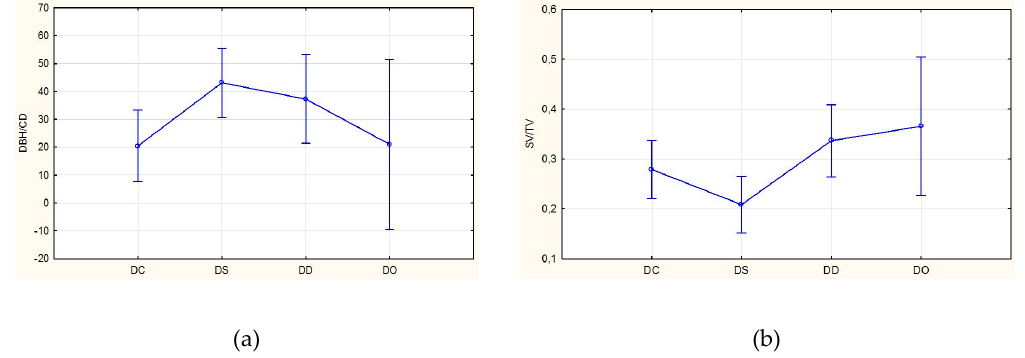
Figure 9. (a) Stem volume coefficient (SVC) computed as the ratio of stem volume to total volume (SV / TV). ( b ) Stem diameter coefficient (SDC) computed as the ratio of diameter at breast height to canopy depth (DBH/CD). Key: DC—Dracaena cinnabari; DS—D. serrulata; DD—D. draco; DO—D. ombet.